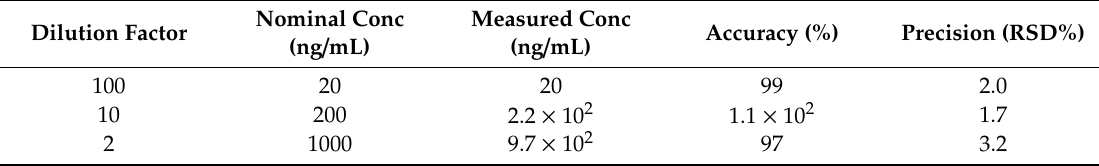
Table 3. Dilution integrity of lekethromycin in rat plasma (n = 6).